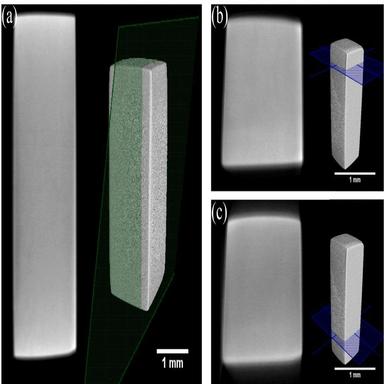
Examples of CT scan images of the SPS_Cu3B sample. (a) Side view image with 0.65 mm distance from the right side of the sample (b) Top view with 5.5 mm distance from the bottom (c) Top view with 1.55 mm distance from the bottom of the sample.